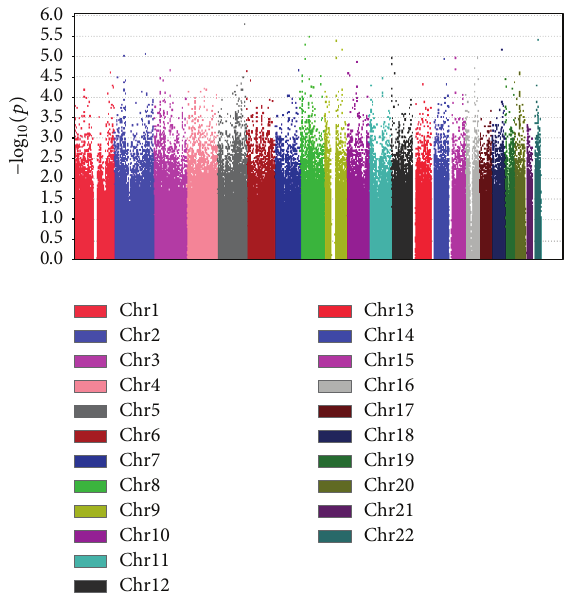
Figure 3: Manhattan plot summarizing the genome-wide associa- tion results. Smallest 𝑝 = 1.62𝑒 − 6 (adjusted 𝑝 = 0.328